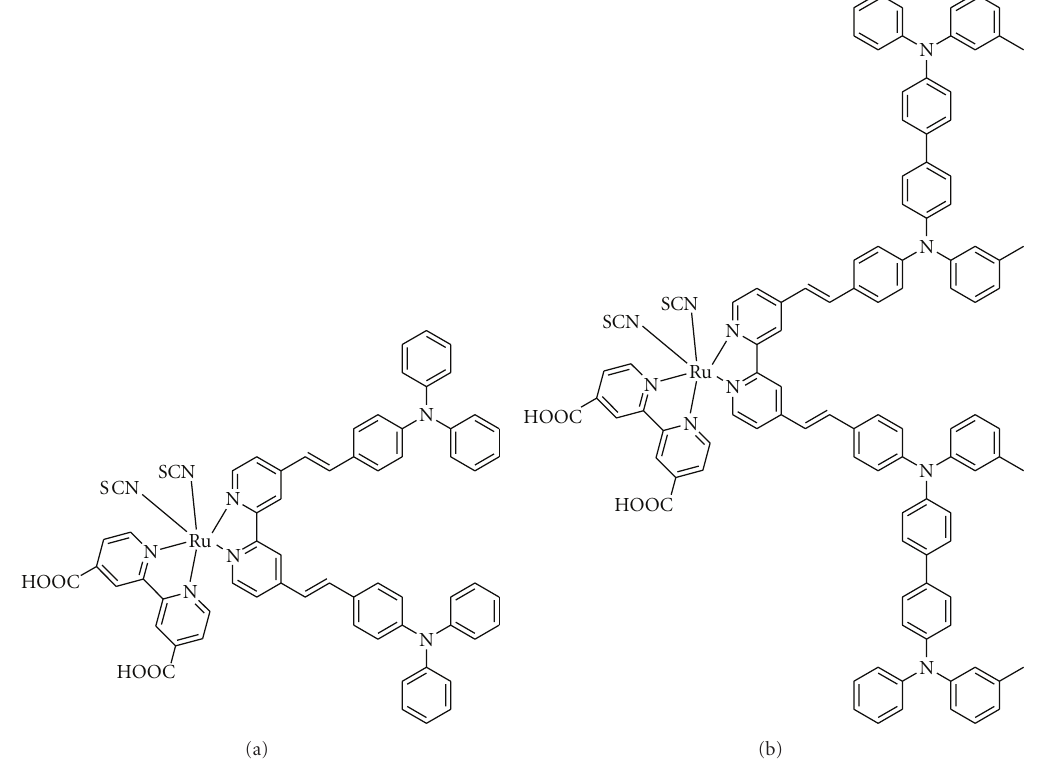
Figure 17: Molecular structures of (a) Ru-TPA-NCS, and (b) Ru-TPD-NCS (taken from [35]).